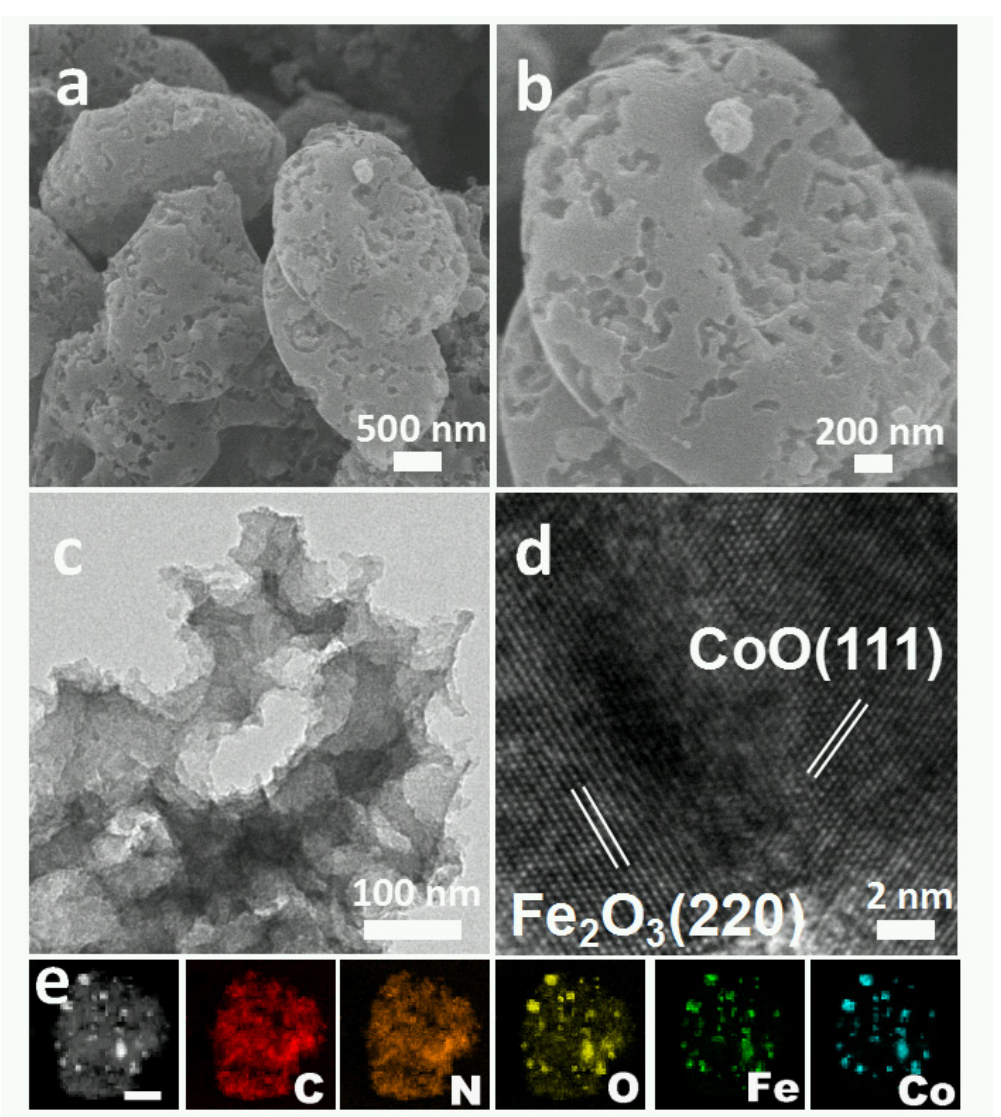
Figure 2. ( a , b ) FESEM images of FeCo-N/C (RBC) . ( c ) TEM images of FeCo-N/C (RBC) . ( d ) HR-TEM images of FeCo-N/C (RBC) . ( e ) TEM image of FeCo-N/C (RBC) and the corresponding elemental mappings, the scale of length is 1 μ m.